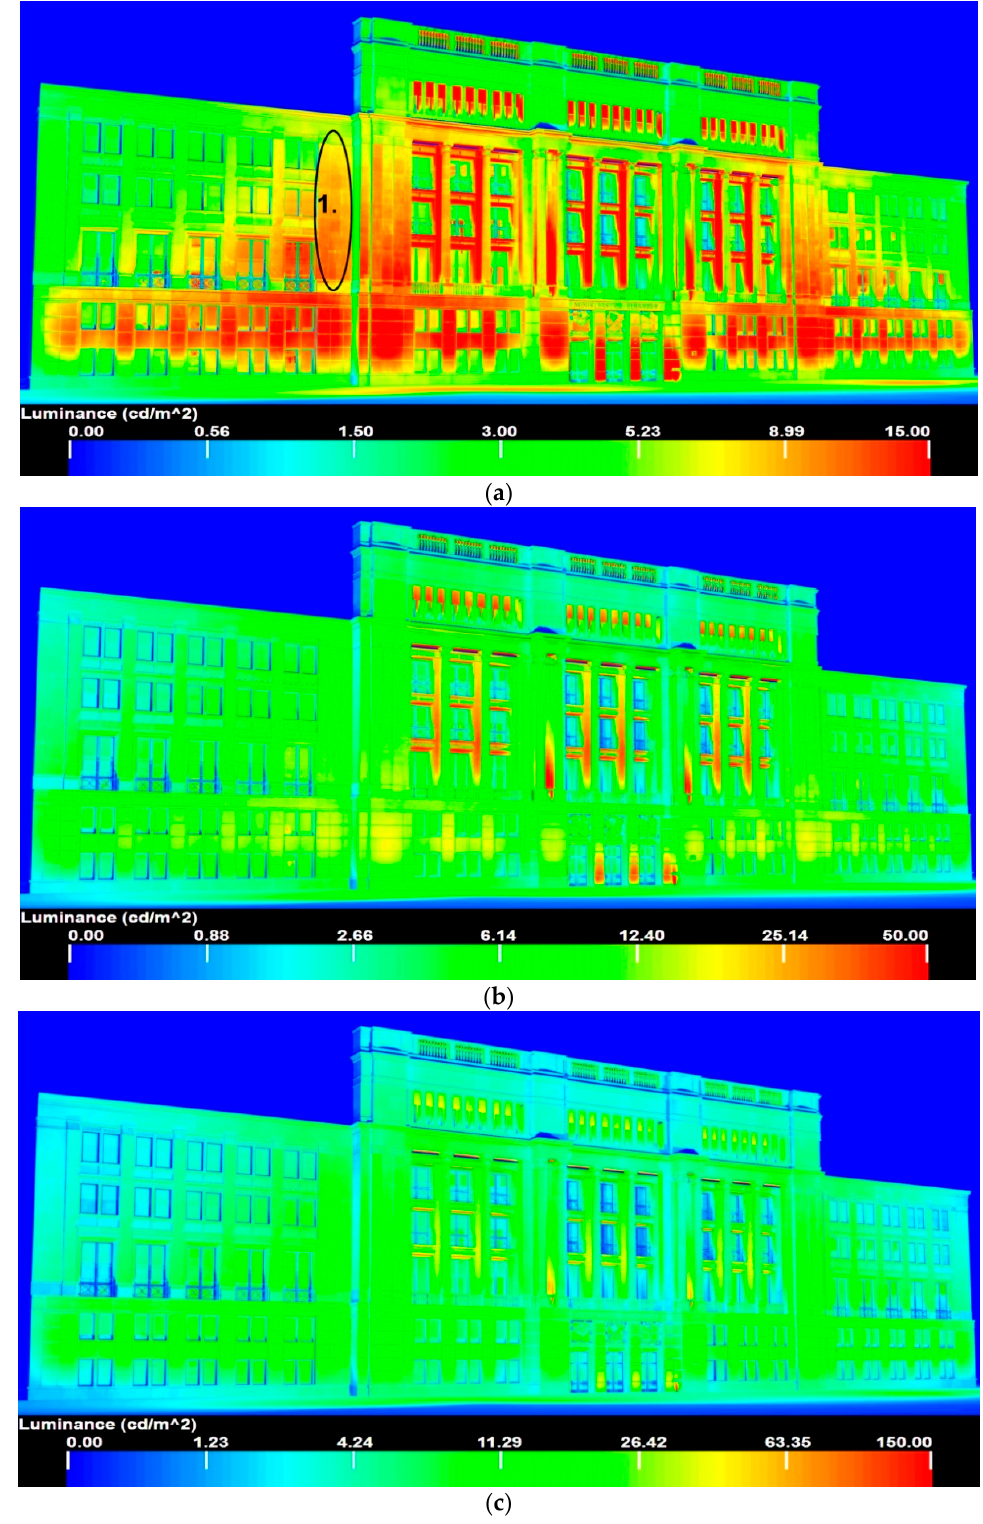
Figure 6. The same luminance distribution shown by means of the falsecolour image using different ranges: ( a ) 0–15 cd/m 2 , ( b ) 0–50 cd/m 2 and ( c ) 0–150 cd/m 2 .